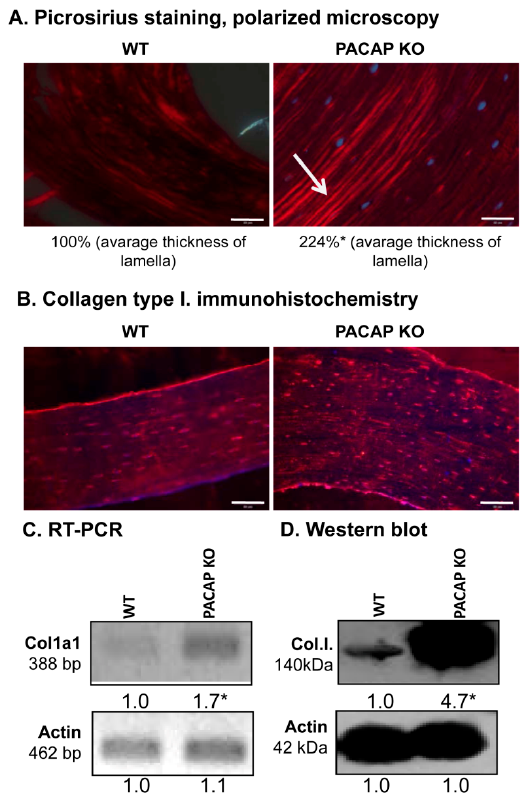
Figure 3. Collagen type I expression in femurs. ( A ) Collagen expression of cortical bone was visualized with picrosirius staining, and photomicrographs were made by polarization microscope. Original magnification was 20 × . Scale bar: 200 µ m. Numbers below the photos show the differences of concentric lamellas thickness. ( B ) Immunohistochemistry of collagen type I in cortical bones. Original magnification was 20 × . Scale bar: 200 µ m. mRNA ( C ) and protein ( D ) expression of collagen type I. For RT-PCR and Western blot reactions, actin was used as controls. Optical signal density was measured and results were normalised to the controls. For panels ( C , D ) numbers below signals represent integrated signal densities determined by ImageJ software. Asterisks indicate significant (* p <0.05) alteration of expression compared to the respective controls. Representative data of 3 independent